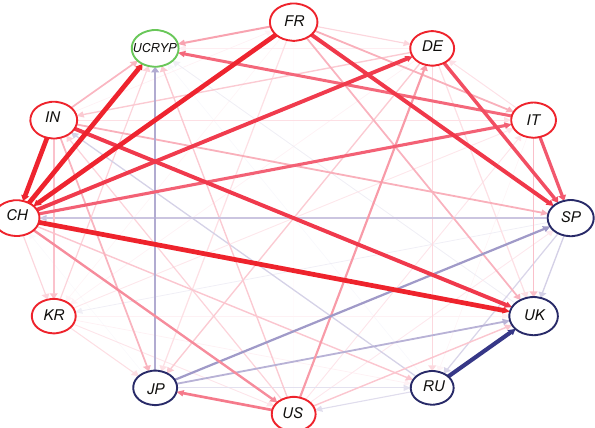
Figure 1. Pairwise spillover network